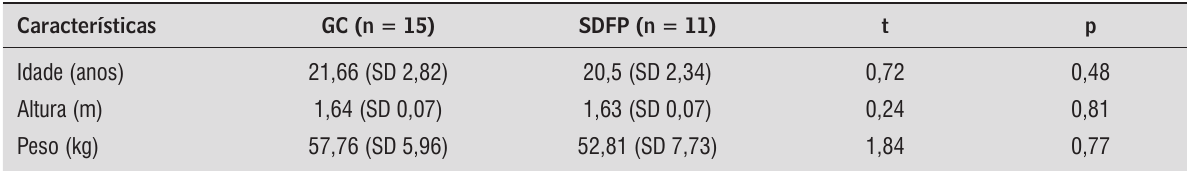
Tabela 1 - Média, desvio-padrão e teste t de Student das características dos sujeitos dos grupos controle (GC) e com dis- função femoropatelar